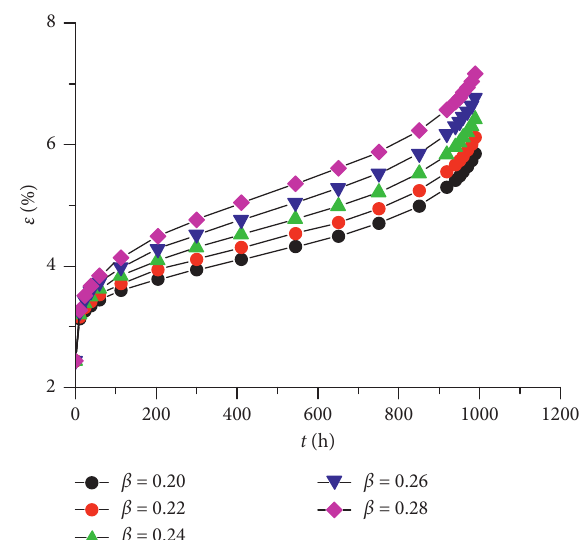
Figure 6: Sensitivity of the creep strain to fractional derivative order β ( σ � 14.41MPa, σ s � 13.5MPa, E � 0.590GPa, ξ � 3.662GPa · h β , t F � 1056h, and α � 0.191).